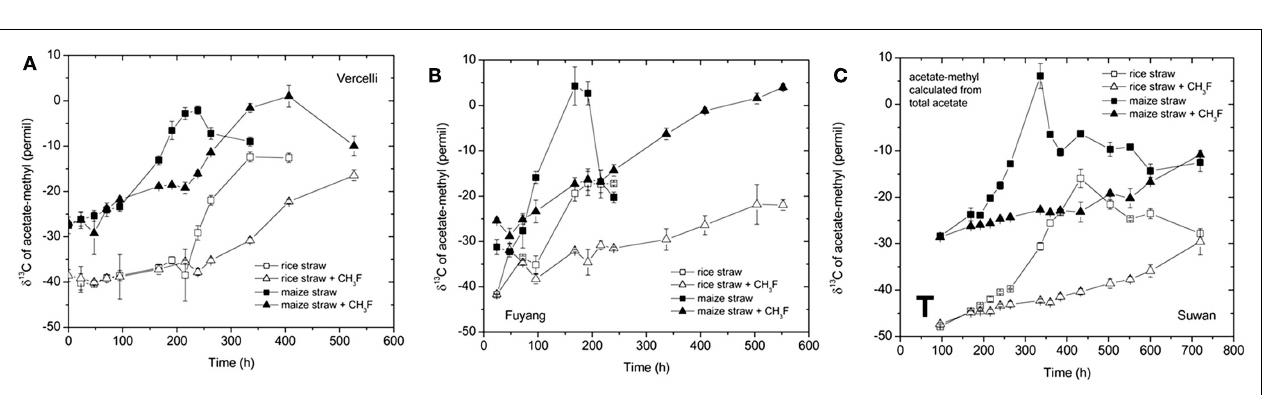
FIGURE 5 |Values of δ 13 C of the methyl group of acetate accumulated in soil from (A)Vercelli, (B) Fuyang, and (C) Suwan, amended with either rice straw or maize straw and incubated under anoxic conditions in the absence or presence of CH 3 F (1, 2, and 2%